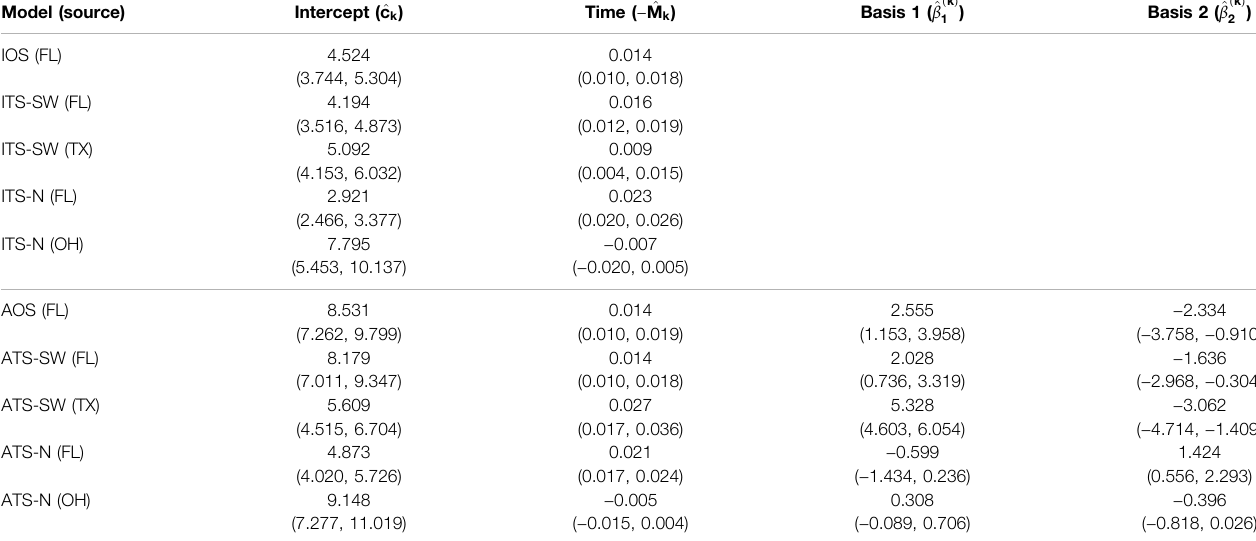
TABLE 4| Parameterestimates and95%con fi dence intervalsforone-and two-sourcemodels fi tto2009data( n (cid:1) 65).Inthetwo-sourcemodels, twosetsofestimatesare reported corresponding to a northern placement and a southwestern placement for the alternate (non-FL) source. No basis parameters are reported for the isotropic models, since these terms are only included in the anisotropic models (FL - Florida, TX - Texas, OH -